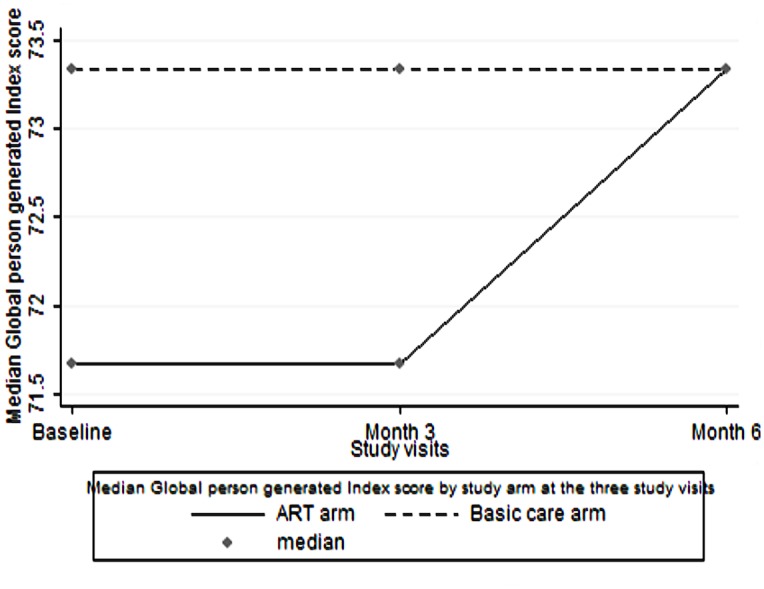
Median Global Person Generated Index score over six months.Comparison of Global Person Generated Index score medians ART versus basic care among PLHIV over the follow up period.